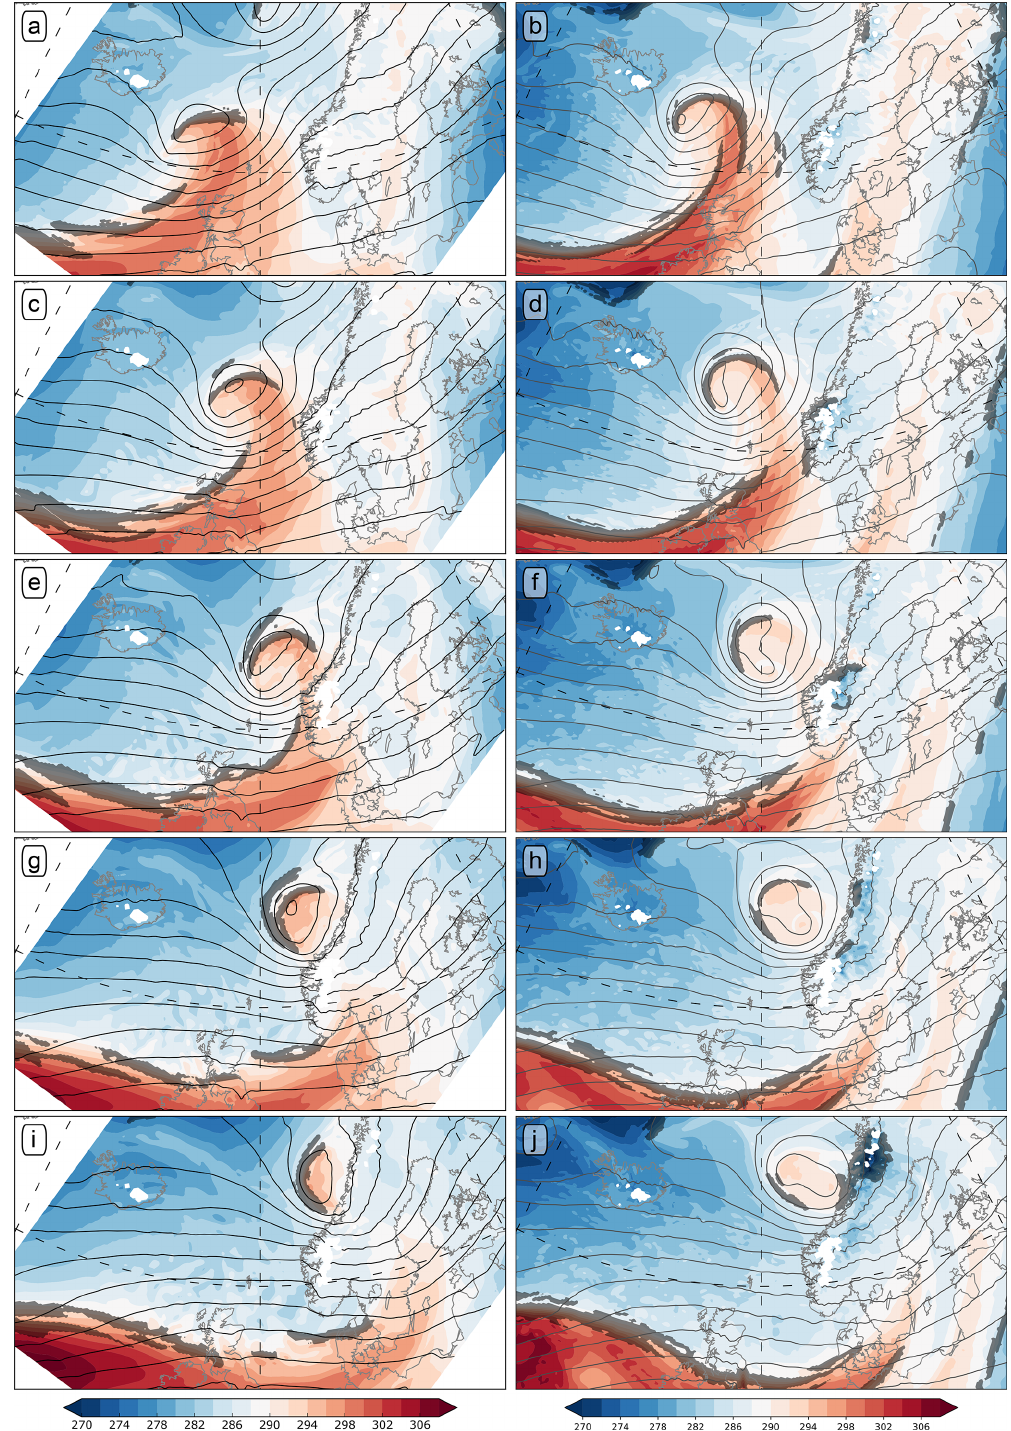
Figure 2. Frontal evolution for the New Year’s Day Storm at 850hPa. Equivalent potential temperature shading (K) and geopotential height contours with an interval of 50m. Detected frontal zones are marked by dark shading. The panels show the development from (top row) 00:00UTC through (bottom row) 12:00UTC on 1 January 1992 in 3h intervals. The left column is based on the NORA10 hindcasts and the right on the Control